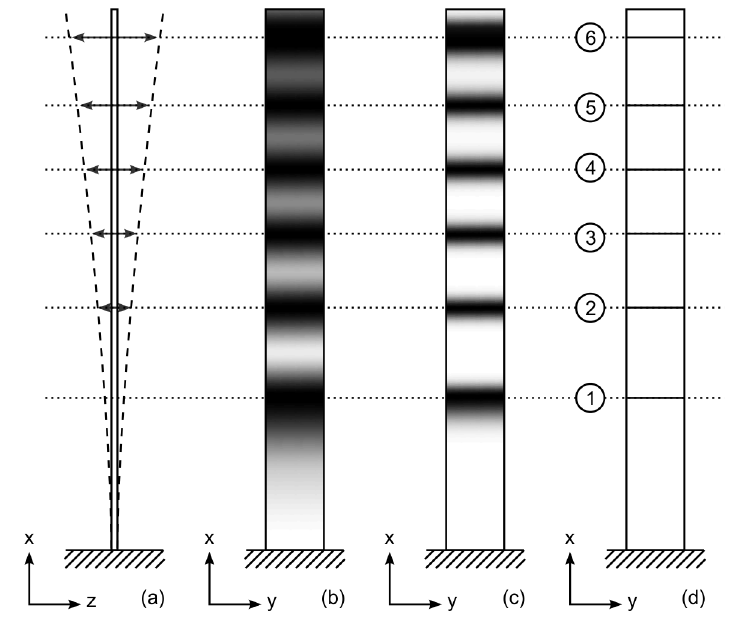
Figure 1. A schematic diagram illustrating the formation of time-averaged holographic fringes: the one-dimensional structure oscillating according to its first eigenform is shown in part ( a ); corresponding gray-scale image in the holographic plane is represented in part ( b ); the contrast enhanced time-averaged hologram is shown in part ( c ); centerlines of time-averaged fringes and their consecutive numbers are represented in part ( d